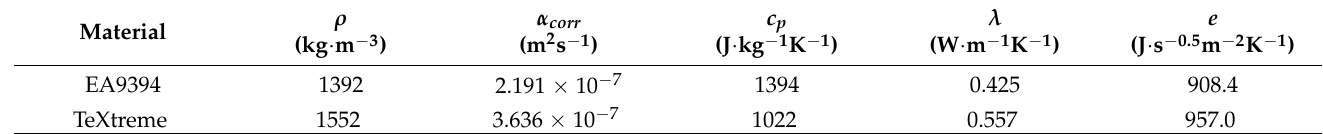
Table 5. Determined thermal